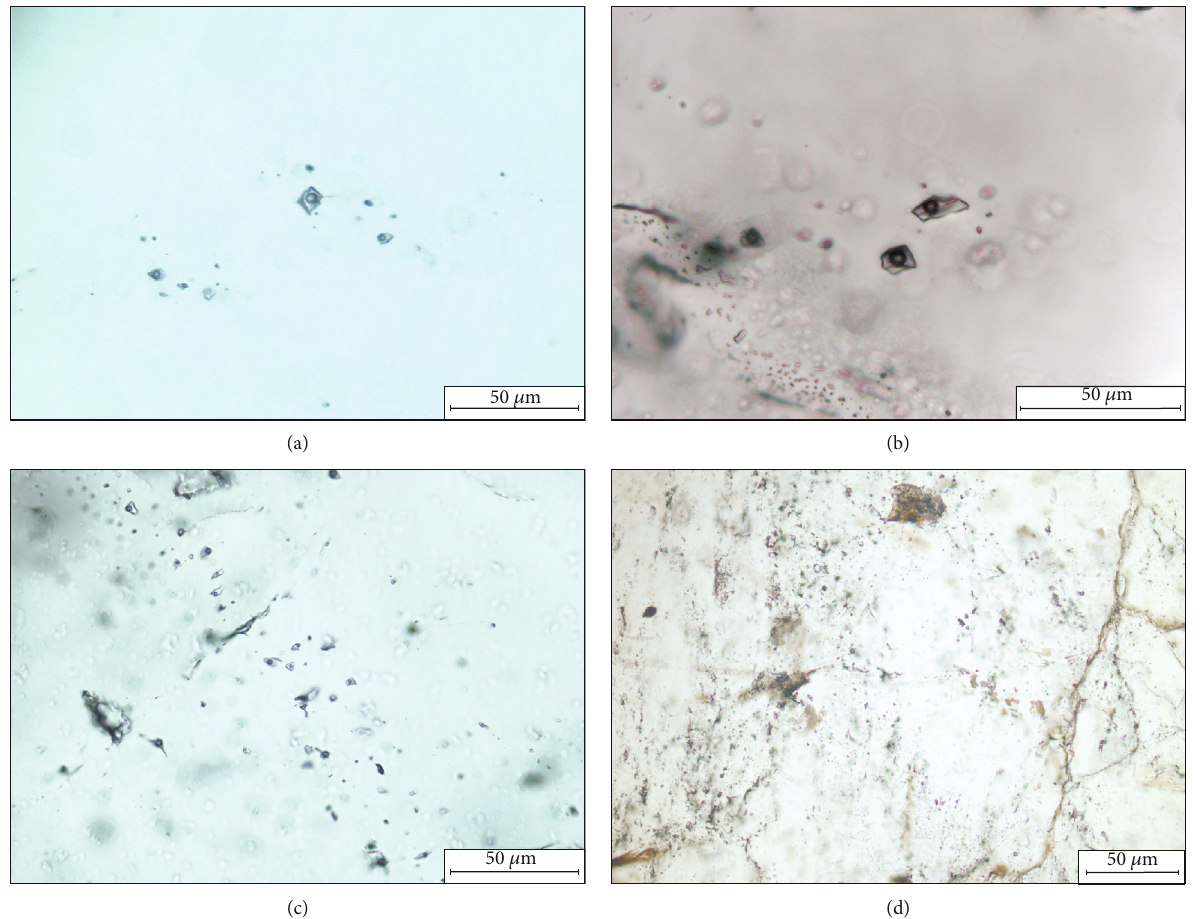
Figure 2: Fluid inclusions distributed in quartz: (a, b) star distribution; (c) strip distribution; (d) predominate group